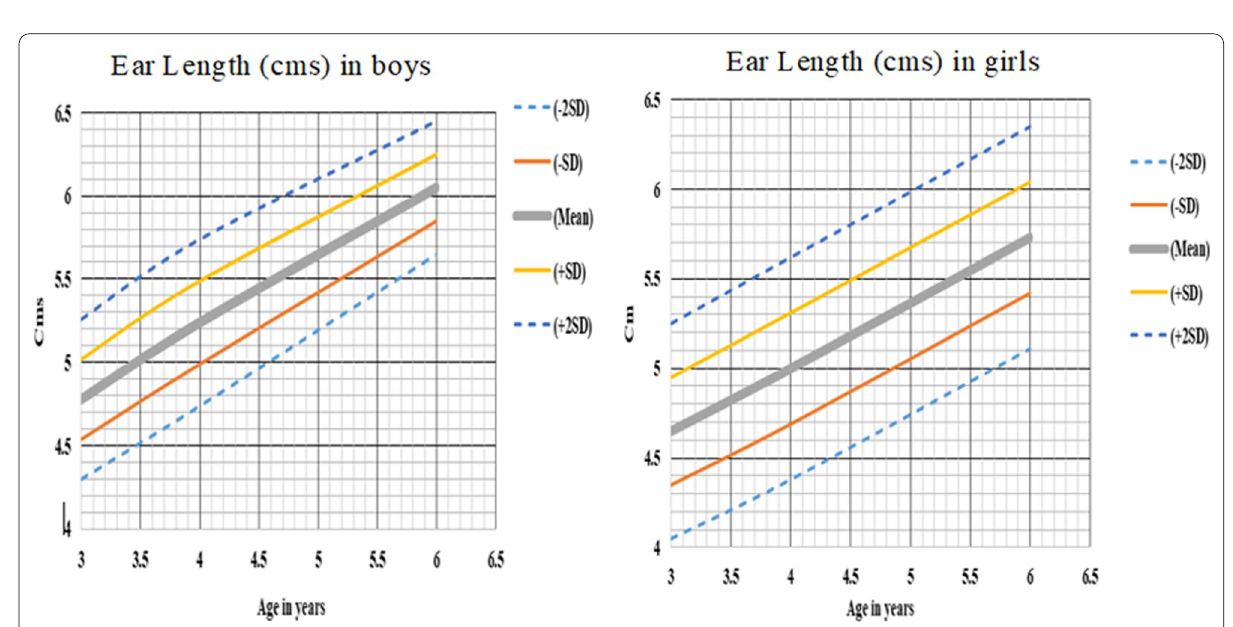
Fig. 11 Ear length (cm) in boys and